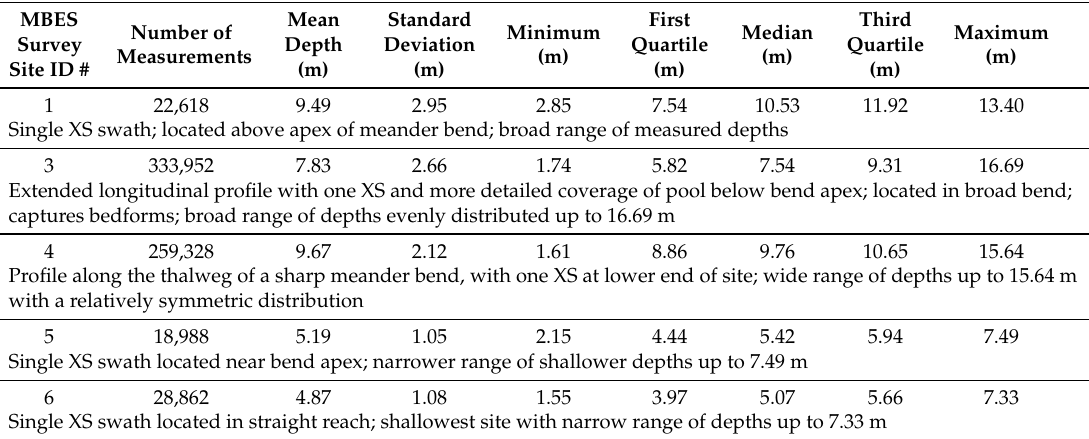
Summary statistics for field-based depth measurements derived from a multibeam echosounder (MBES) survey of five sites along the Kootenai River, along with a description of each of the sites shown in Figure 1. Site #2 was excluded due to the presence of dye from a tracer experiment at this location at the time the image data were acquired. XS is shorthand for cross section, or data collected as a lateral transect across the